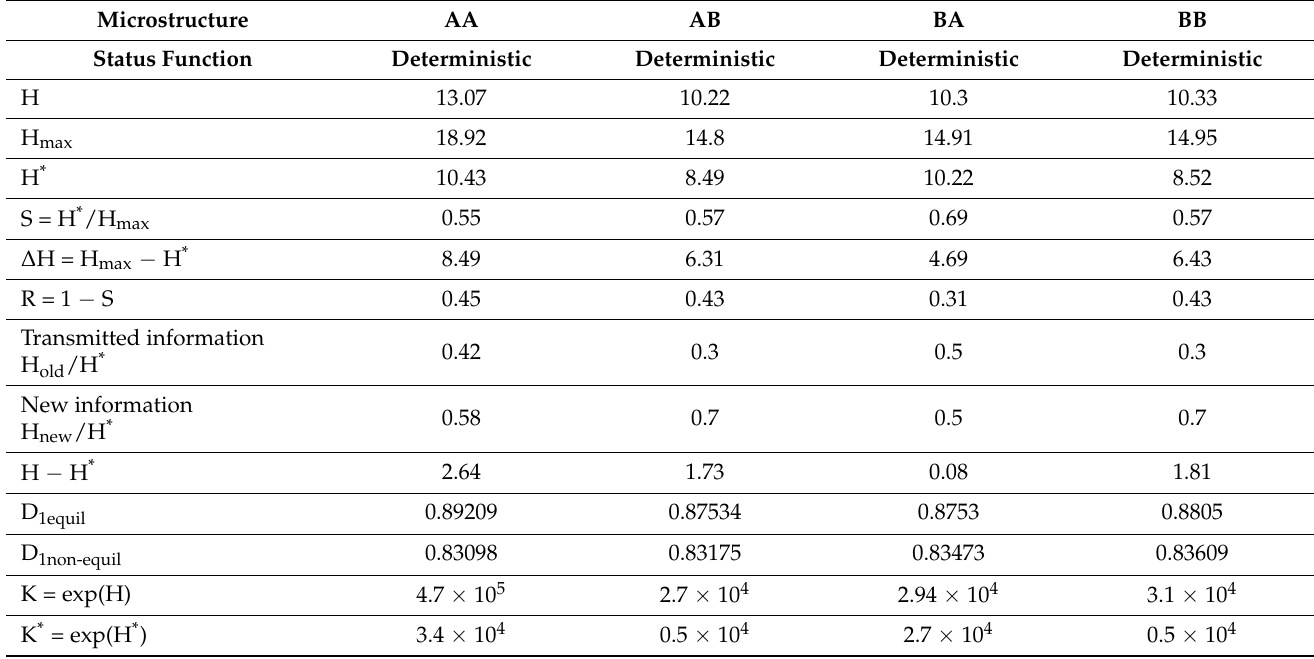
Figure 3. Results of the multifractal analysis of the electron microscopic image of control sample structure: the effect of the d scale on the information entropy of D1 and ∆D. Table 1. Entropy parameters of the control additive-free sample.